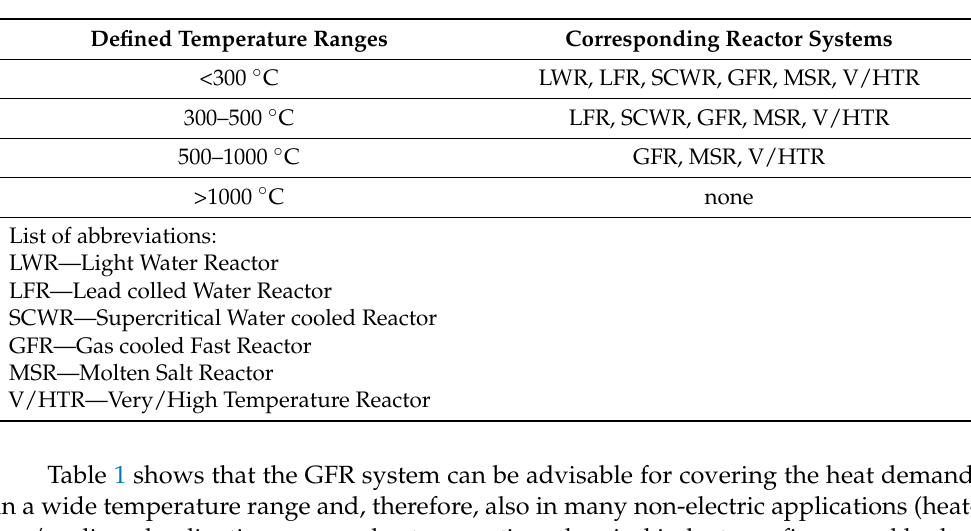
Table 1. Operating temperature ranges of nuclear reactor